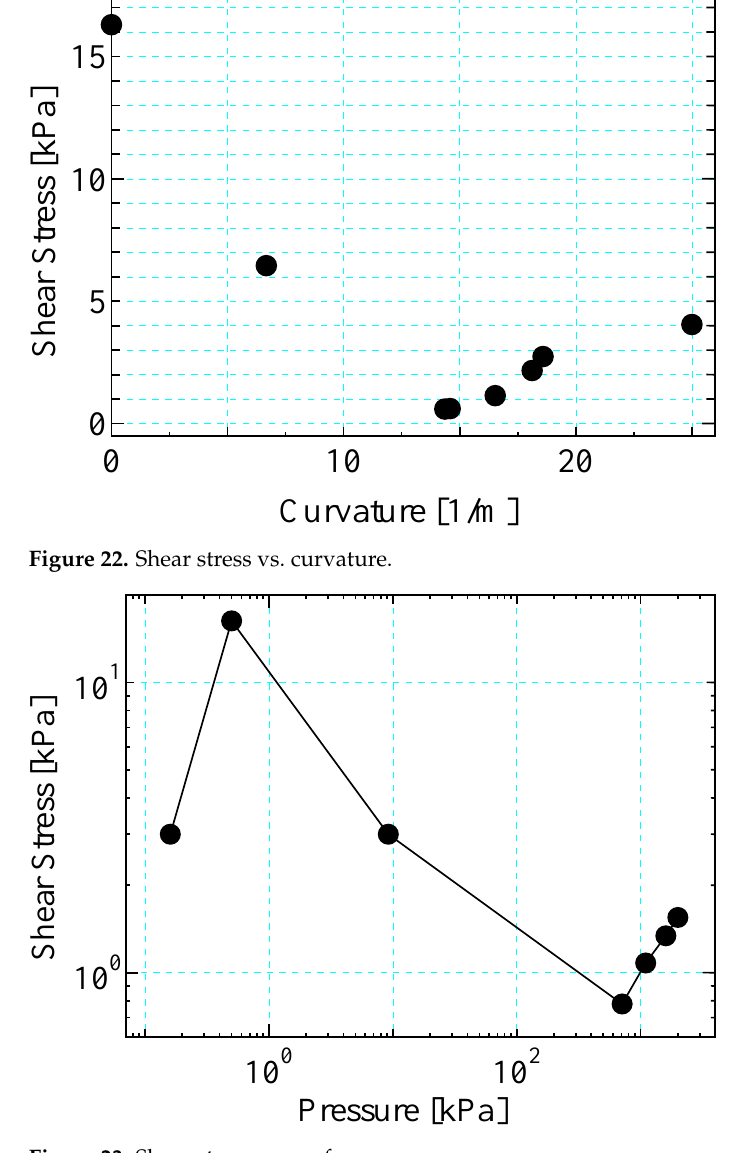
Figure 23. Shear stress vs. surface